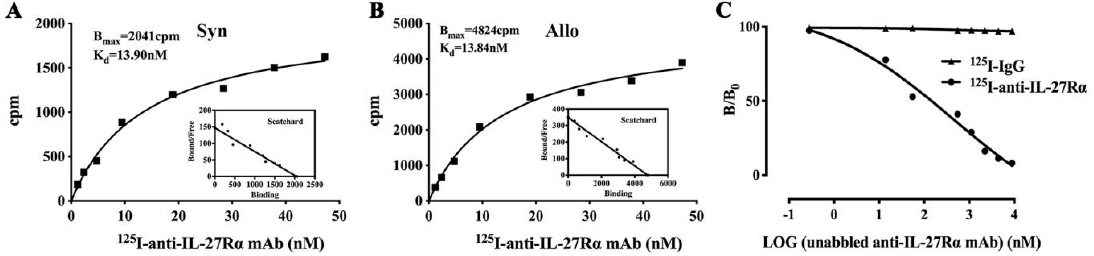
Figure 2. Preparation of 125 I-anti-IL-27R α mAb and 125 I-IgG. The anti-IL-27R α mAb and isotype IgG was labeled with radioiodine 125. ( A ). Saturation assay of syngeneic spleen cells; ( B ). Saturation assay of allogeneic reactive spleen cells. ( C ). Competition binding assay of allogeneic reactive spleen cells.